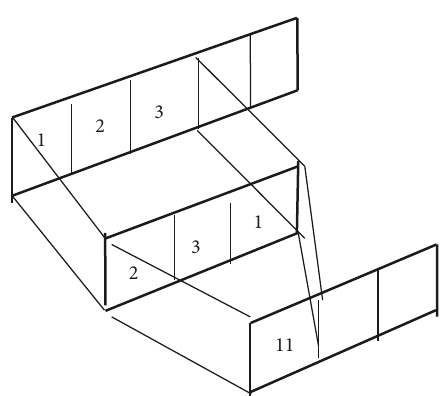
Figure 7: Schematic diagram of the convolution operation.